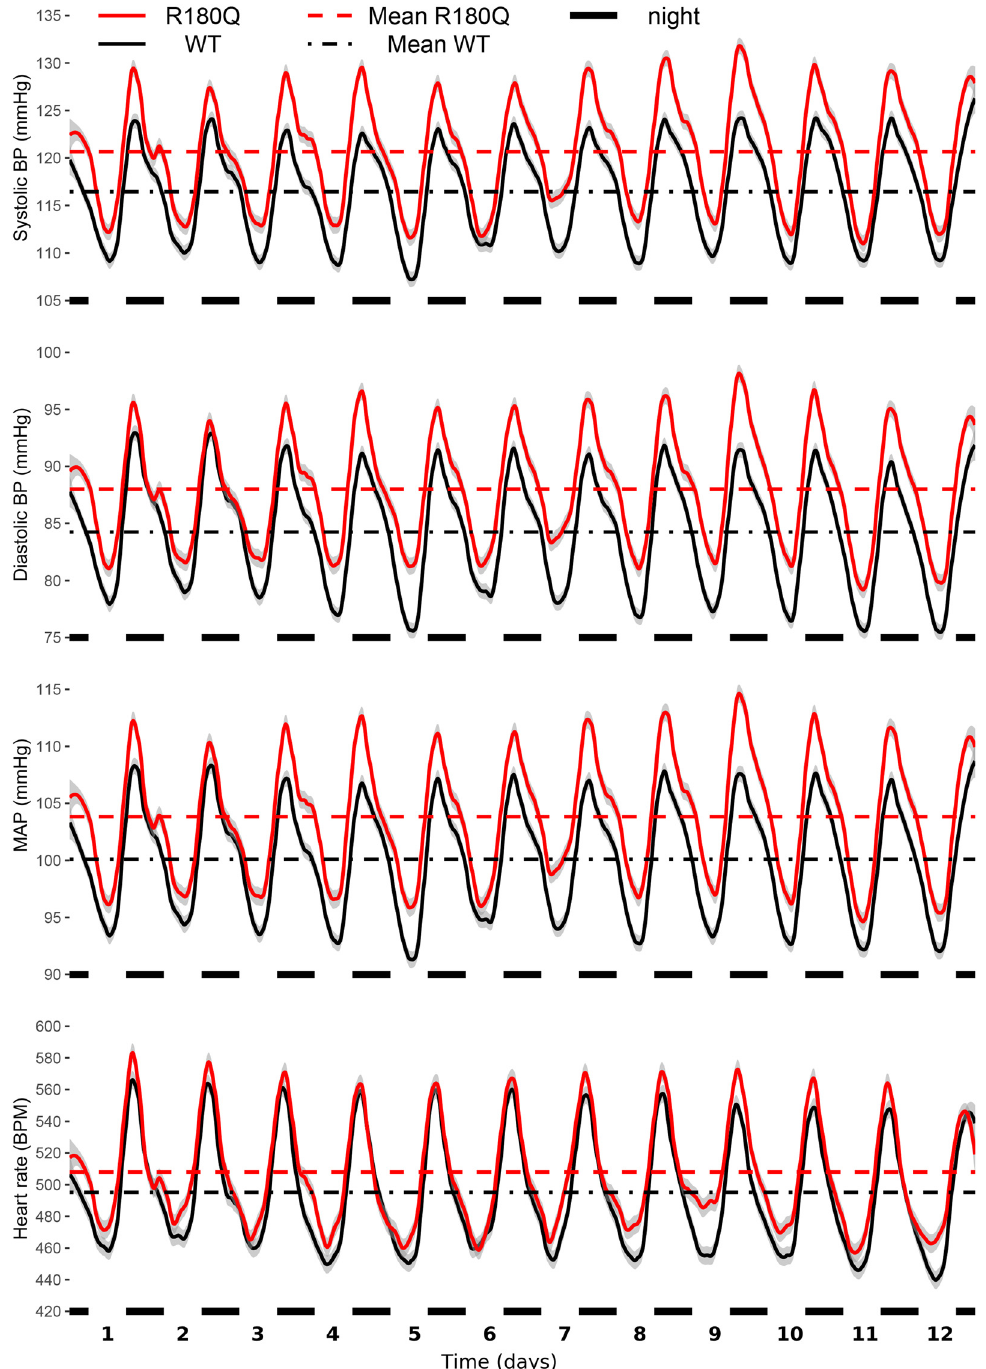
Fig. 7 Clcn2 R180Q/ + mice have higher blood pressure. Blood pressure (BP) and heart rate (HR) of animals assessed through telemetry sensors. Shown are loess regressions of BP/HR of WT (black, N = 18 biologically independent animals) and Clcn2 R180Q/ + (red, N = 18 biologically independent animals) animals, with gray intervals denoting 95% con fi dence intervals for loess regressions. Horizontal axis shows time, with black markers noting nights (active periods of nocturnal animals). Horizontal lines show mean for the entire measurement period for WT (black dash-dotted) and Clcn2 R180Q/ + (red dashed) animals. Nested-model likelihood ratio comparisons reveal signi fi cantly higher BP (systolic, P = 0.007; diastolic P = 0.020, MAP, P = 0.009) of Clcn2 R180Q/ + animals than WT and unchanged HR ( p = 0.225). Average (mean ± SEM for all) systolic BP is 116.4 ± 0.1 mmHg (WT) and 120.6 ± 0.1 mmHg ( Clcn2 R180Q/ + ). Average diastolic BP is 84.2 ± 0.1 mmHg (WT) and 88.0 ± 0.1 mmHg ( Clcn2 R180Q/ + ). Average MAP is 100.1 ± 0.1 mmHg (WT) and 103.8 ± 0.1 mmHg ( Clcn2 R180Q/ + ). Average HR is 495.2 ± 0.4 BPM (WT) and 507.9 ± 0.4 BPM ( Clcn2 R180Q/ +